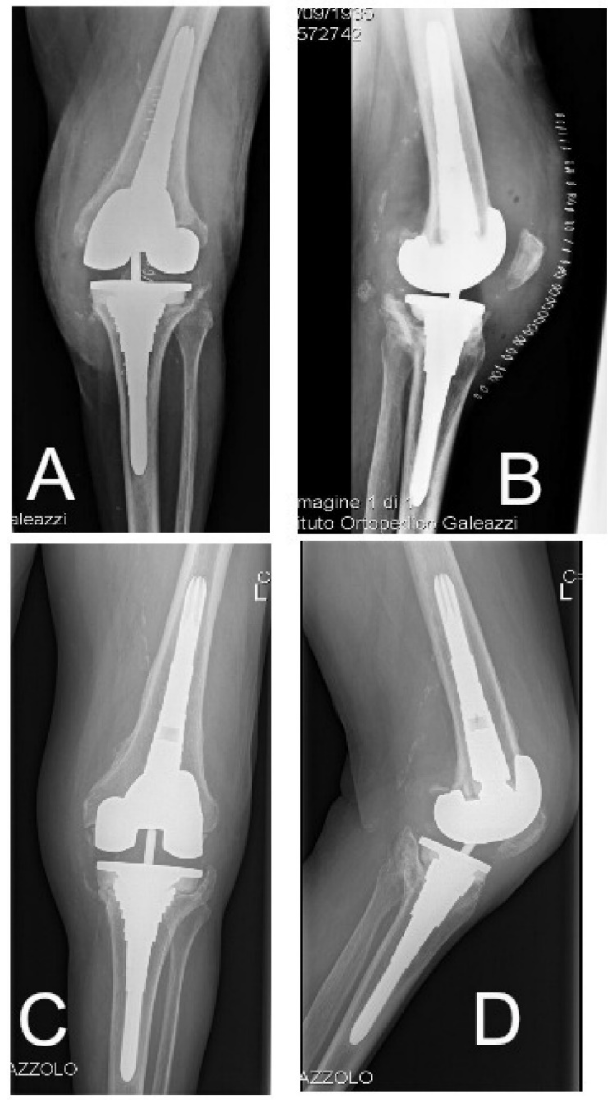
Figure 2 . Plain radiographs of the same patient described in Figure 1 immediately after surgery (A,B), at 12 months